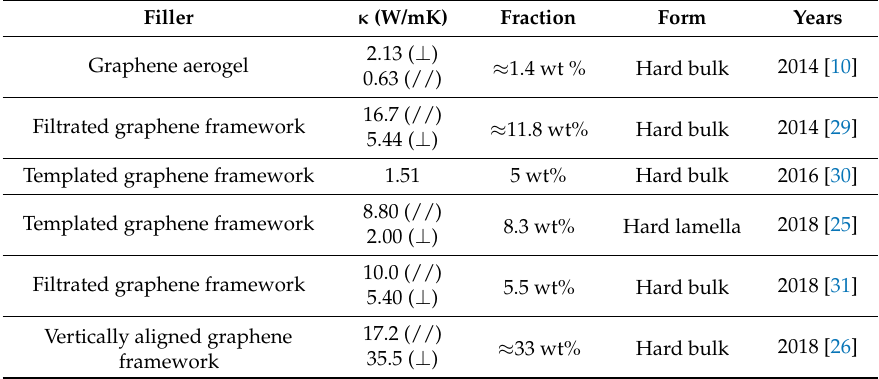
Table 2. Summary of graphene framework/epoxy composites.